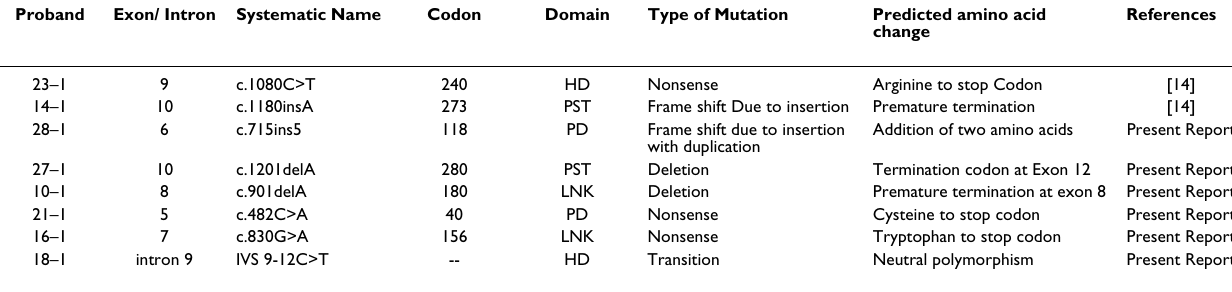
Table 2: Molecular analysis of PAX6 mutations with their predicted products.